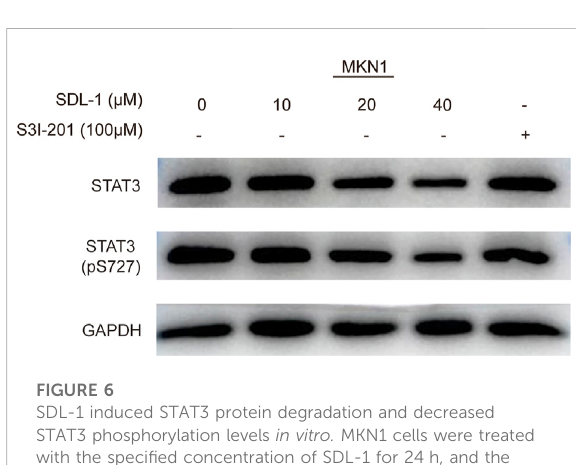
FIGURE 6 SDL-1 induced STAT3 protein degradation and decreased STAT3 phosphorylation levels in vitro. MKN1 cells were treated with the speci fi ed concentration of SDL-1 for 24 h, and the contents of various proteins in MKN1 cells were detected by Western